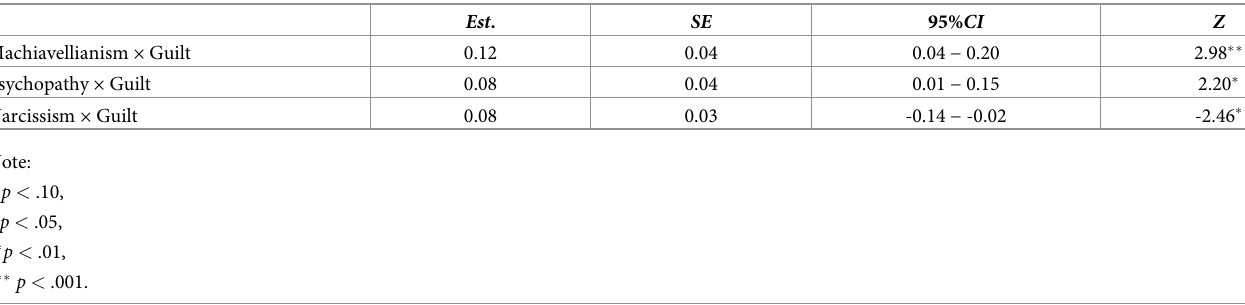
Table 3. Results of indirect effects in the generalized SEM for mediation